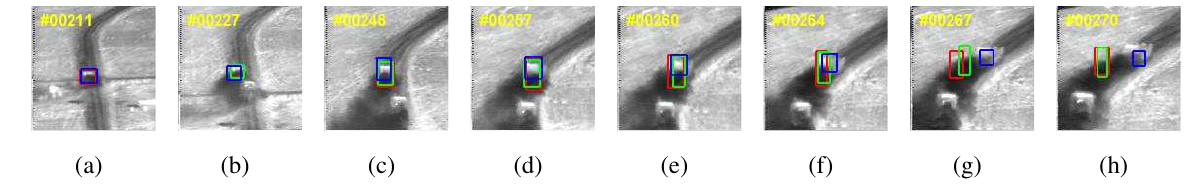
Figure 3. Tracking results of three trackers for sequence